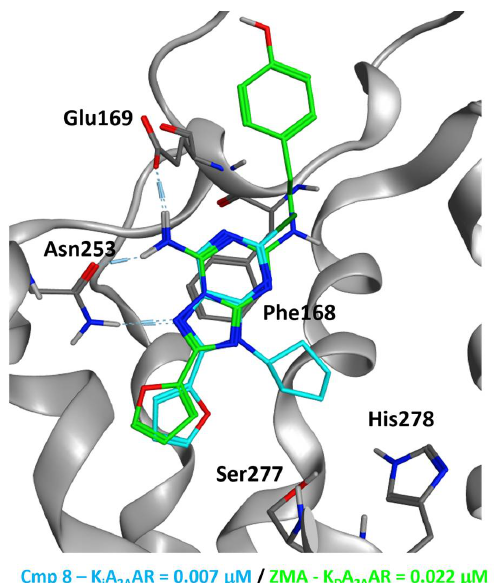
Figure 7. Comparison between the selected pose of compound 8 (colored in cyan, K i A 2A AR = 7 nM) and the crystallographic conformation of ZM 241385 (ZMA, taken from the crystal with PDB code 5K2C, colored in light green, K D A 2A AR = 22 nM). The main residues surrounding the two molecules in the pocket are labeled, and the hydrogen bonds are represented with dashed lines. All of the images were created and rendered with MOE.